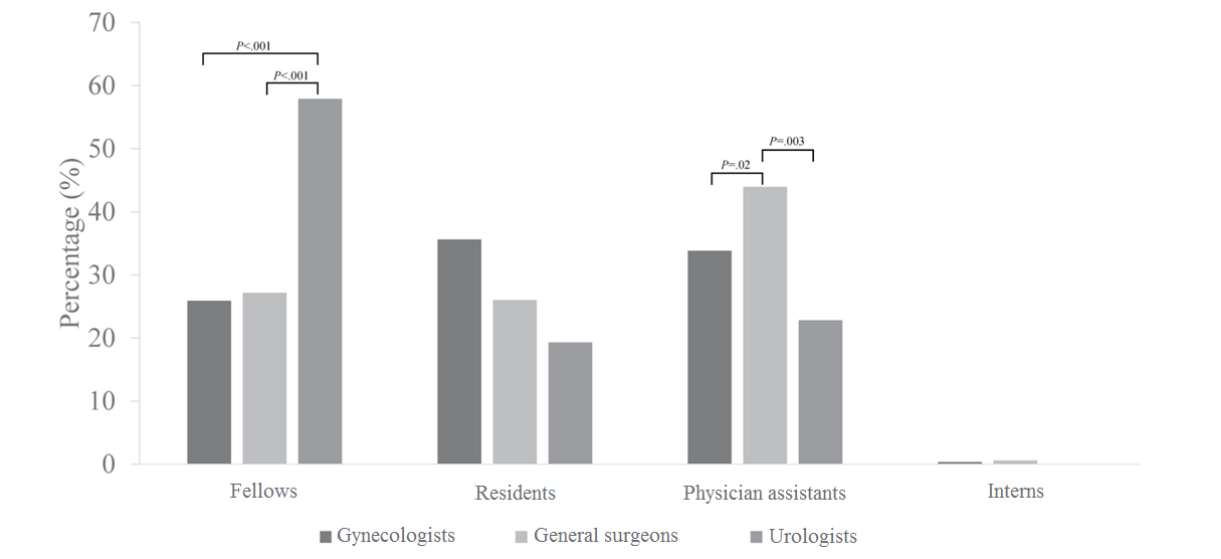
Figure 1. Comparison of assistants preferred during laparoscopic